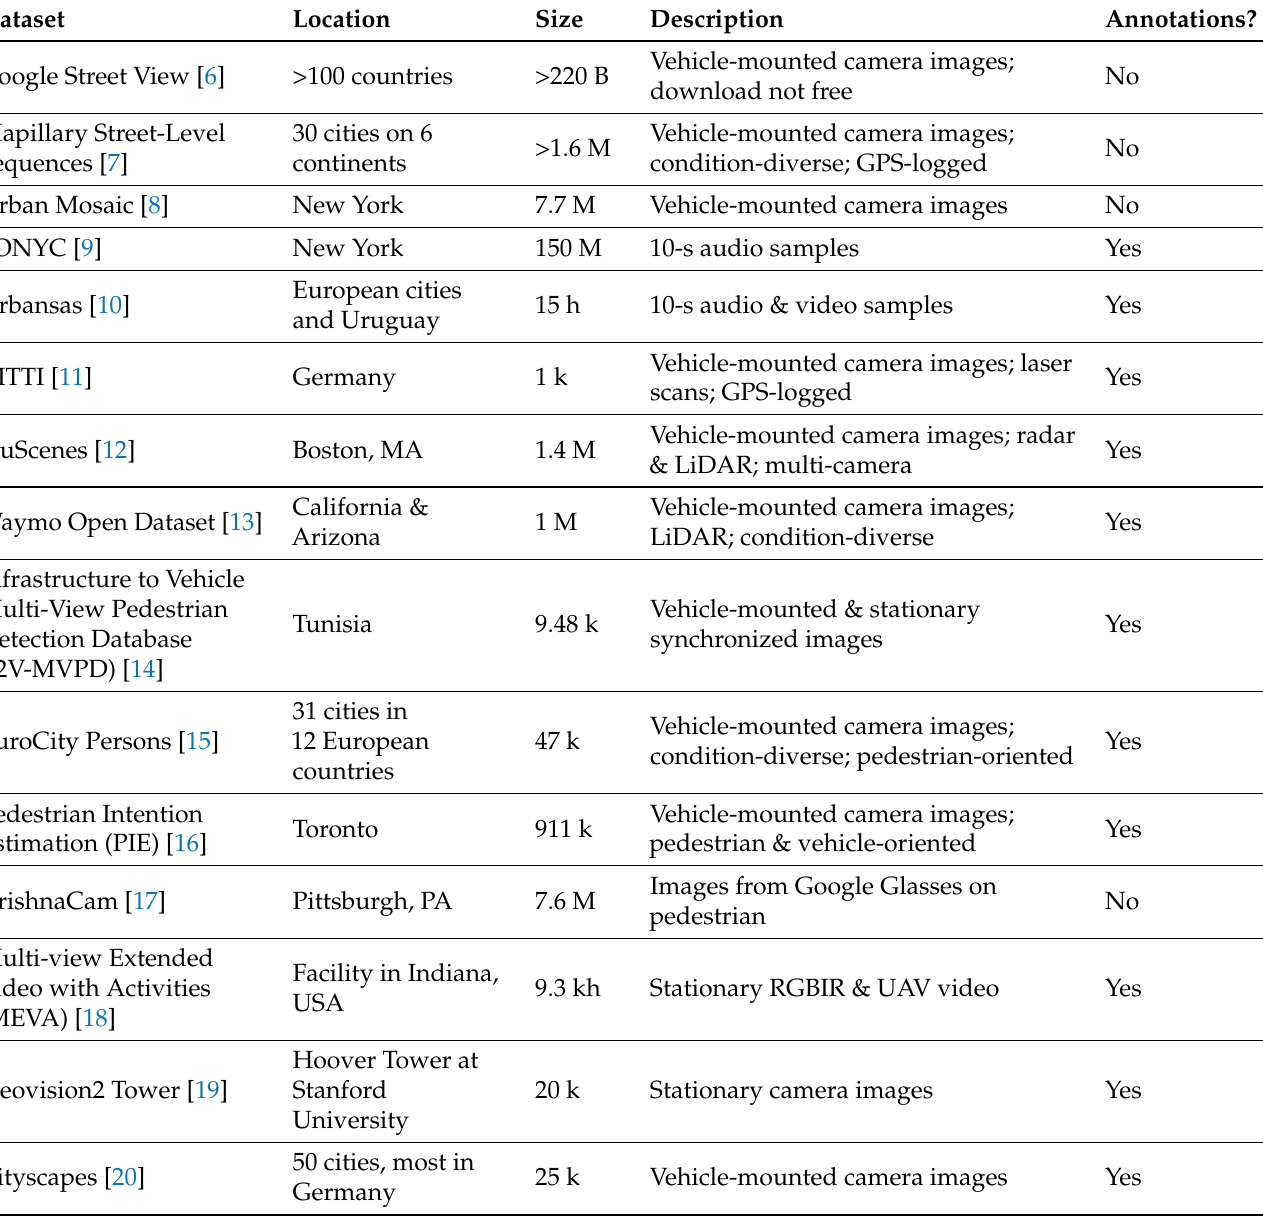
Table 1. Summary of available street-level datasets with their locations, sizes, descriptions, and whether or not they contain